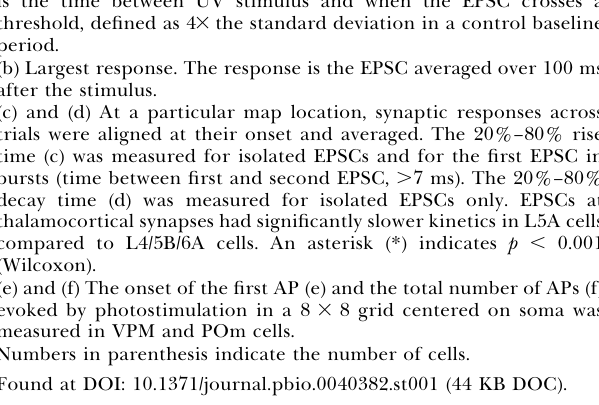
Table S1. Properties of Photostimulation-Evoked Synaptic Responses in Cortical Neurons and Firing in Thalamus (a) The onset for the largest response for each cortical cell. The onset is the time between UV stimulus and when the EPSC crosses a threshold, defined as 4 3 the standard deviation in a control baseline period. (b) Largest response. The response is the EPSC averaged over 100 ms after the stimulus. (c) and (d) At a particular map location, synaptic responses across trials were aligned at their onset and averaged. The 20%–80% rise time (c) was measured for isolated EPSCs and for the first EPSC in bursts (time between first and second EPSC, . 7 ms). The 20%–80% decay time (d) was measured for isolated EPSCs only. EPSCs at thalamocortical synapses had significantly slower kinetics in L5A cells compared to L4/5B/6A cells. An asterisk (*) indicates p , 0.001 (Wilcoxon). (e) and (f) The onset of the first AP (e) and the total number of APs (f) evoked by photostimulation in a 8 3 8 grid centered on soma was measured in VPM and POm cells. Numbers in parenthesis indicate the number of